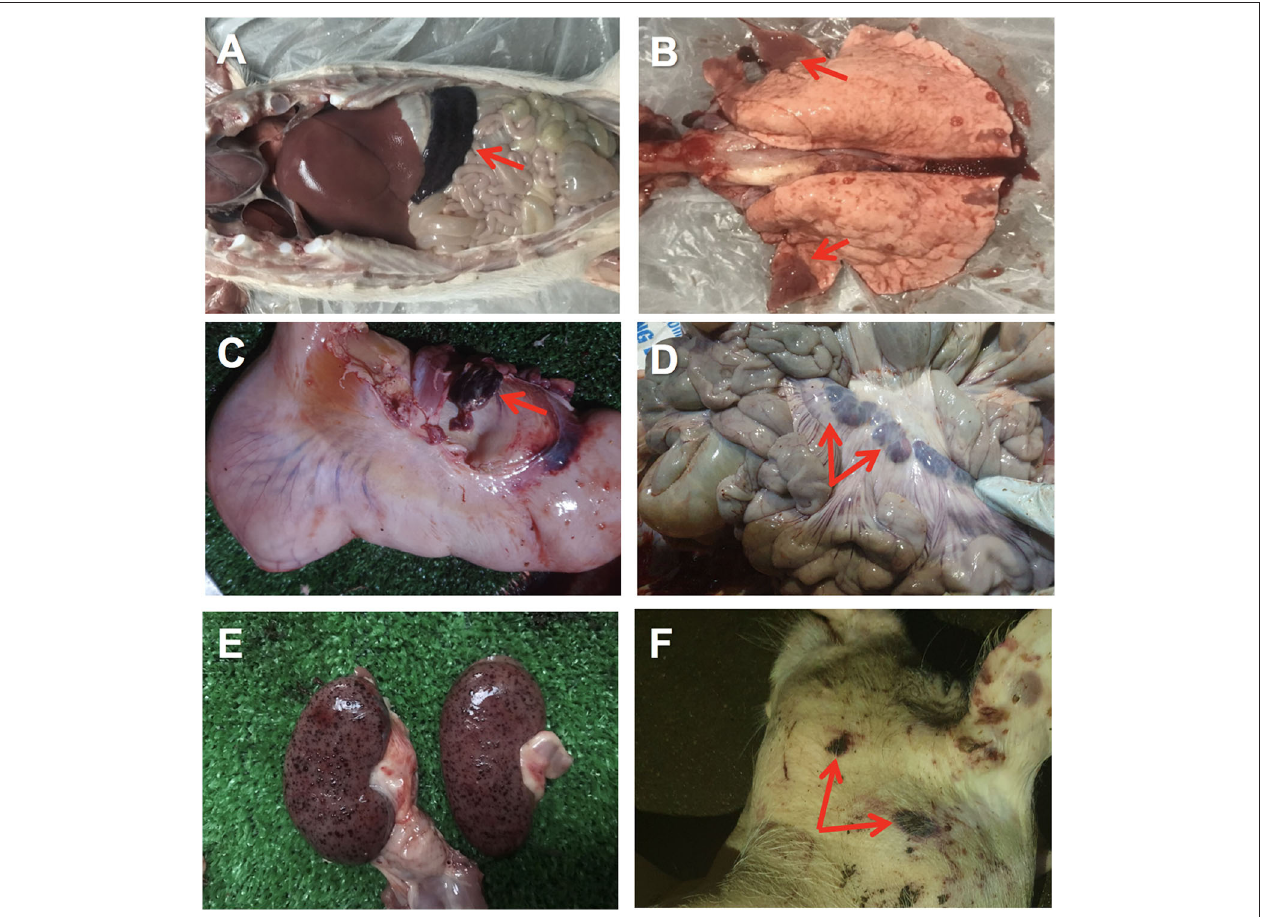
FIGURE 1 | Gross pathology of ASFV infected pigs in Vietnam, 2019. (A) Hemorrhagic splenomegaly (arrow) can be observed at the abdominal cavity inspection. (B) Multiple areas of lung consolidation in cranial lobes (arrows) and multifocal hemorrhages. (C) Hemorrhagic lymphadenitis in the gastrohepatic lymph node (arrow). (D) Haemorrhagic lymphadenitis in the mesenteric lymph nodes (arrows). (E) Multiple severe petechial hemorrhages in the renal cortex. (F) Multifocal hemorrhages on the skin (arrows) of the head and